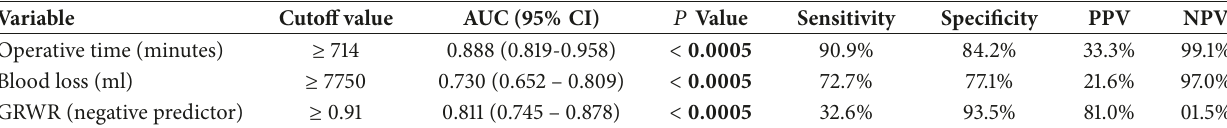
Table 3: Accuracy of operative time, blood loss, and GRWR in predicting renal impairment at one year after liver transplantation. Variable Cutoff value AUC (95% CI) 𝑃